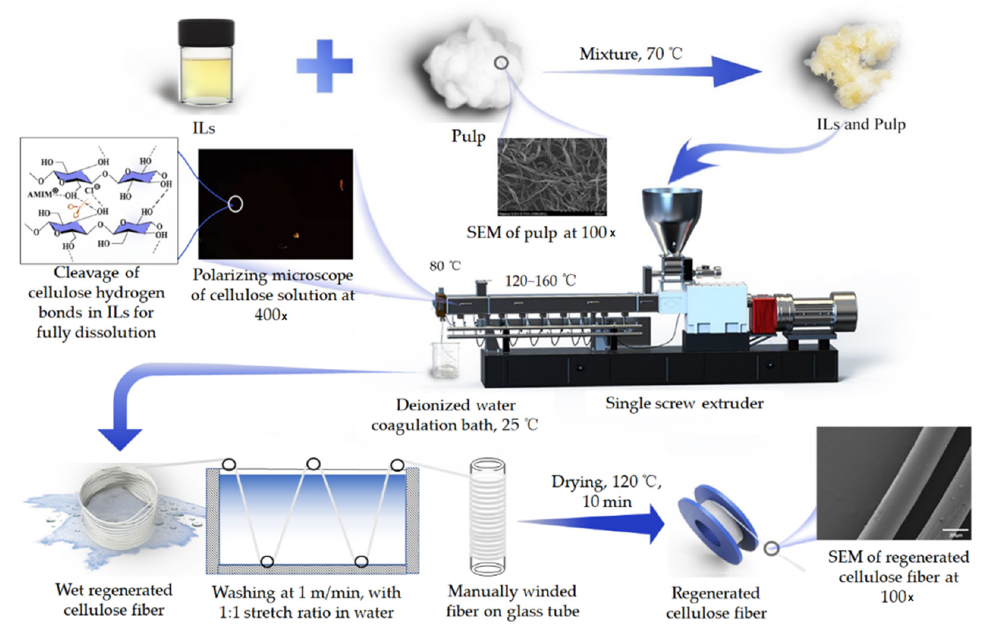
Figure 1. The synthesis procedure of regenerated cellulose fiber: The ionic liquids (ILs) and pulp mixture were put into a single screw extruder, where the cellulose was fully dissolved to form a homogeneous solution (polarizing microscope at 400X, with limited bright spot). The cellulose was regenerated in the coagulation bath, followed by washing and drying to obtain the regenerated cellulose fiber.